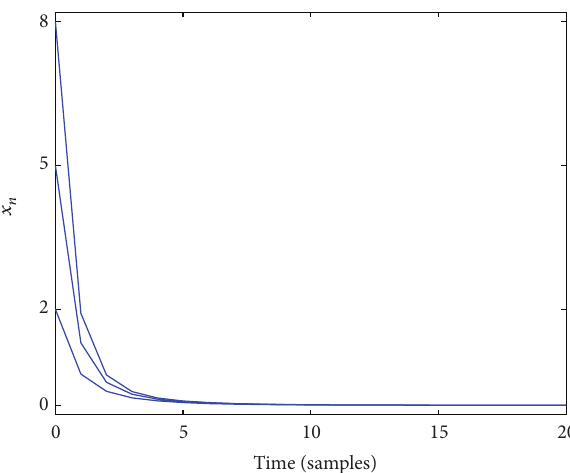
Figure 1: Evolution of the iterates for different initial